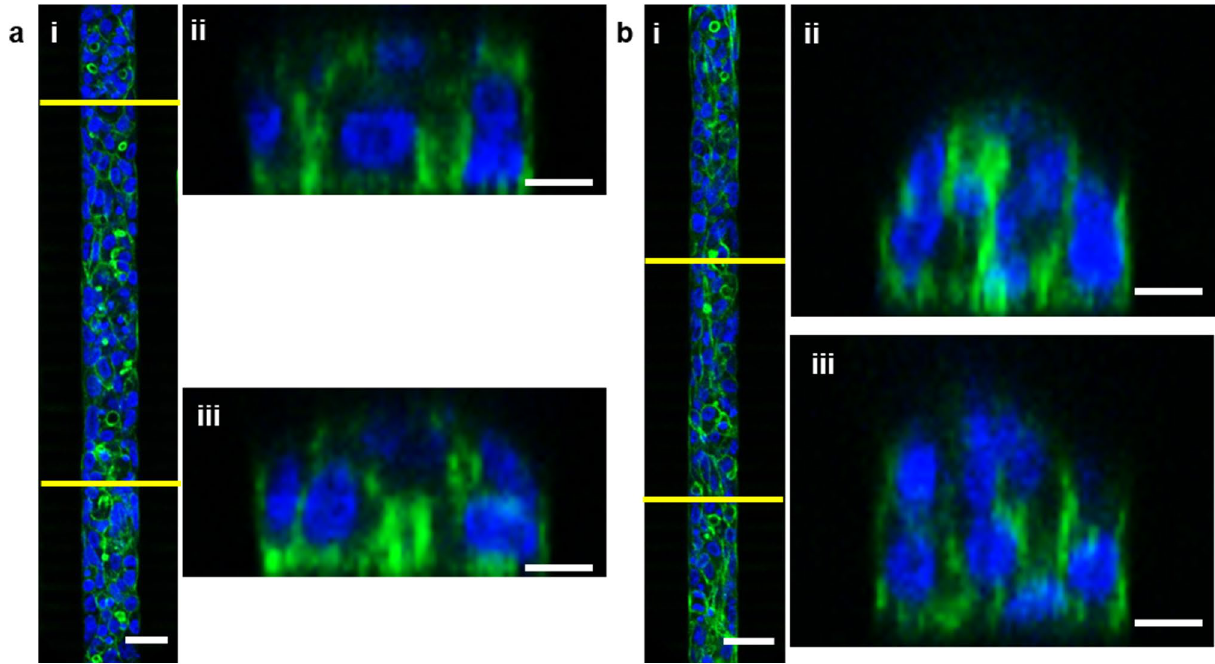
Figure 3. Comparison of cell 3D organisation within two different heights of chambers. Proliferative HepaRG were loaded and observed after 2 days in static conditions by fluorescent staining (blue: DAPI, green: phalloidin) with a confocal microscope. ( a ) Observations on a 25–2 µm device: (i) top-down view, with cross-sections taken at the positions indicated by yellow lines, scale bar = 40 µm; (ii) and (iii) cross-sectional views along the chamber, scale bars = 10 µm. ( b ) Observations on a 40–2 µm device: (i) top-down view, with cross-sections taken at the positions indicated by yellow lines, scale bar = 40 µm; (ii) and (iii) cross-sectional views along the chamber, scale bars = 10